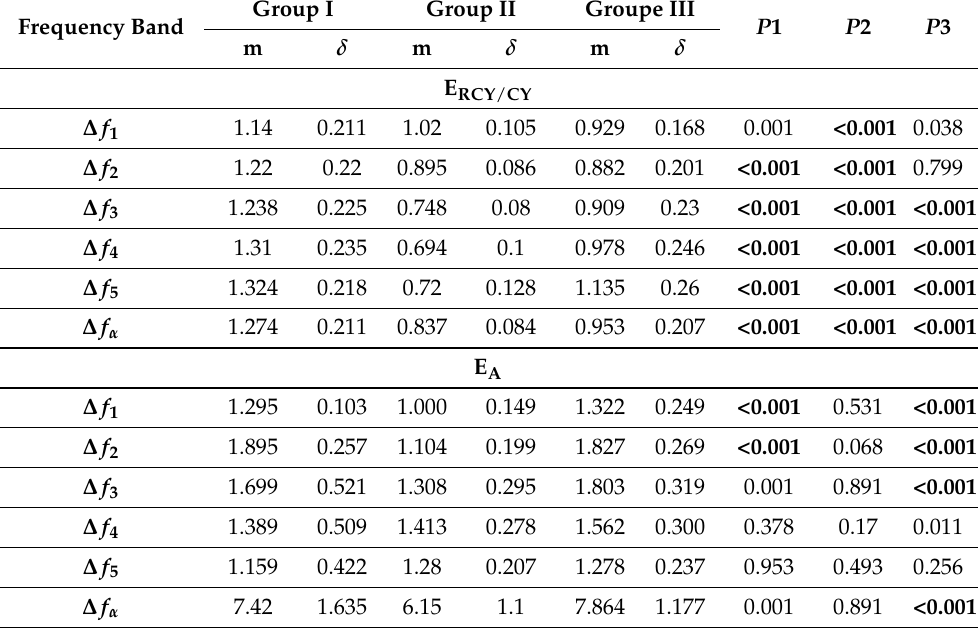
Table 1. Analysis of the energy ratio ERCY / CY and EA for all groups in different frequency bands. m is a median; ∆ is the standard deviation for each frequency interval for the corresponding group; P 1 is the p value of the Group I (control) compared with the Group II (patients with primary insomnia); P 2 is the p value of the Group II compared with the Group III (patients with daytime somnolence); P 3 is the p value of the Group III compared with the Group I (control). All values of p < 0.001 characterize statistically significant differences and are highlighted in bold. Frequency bands